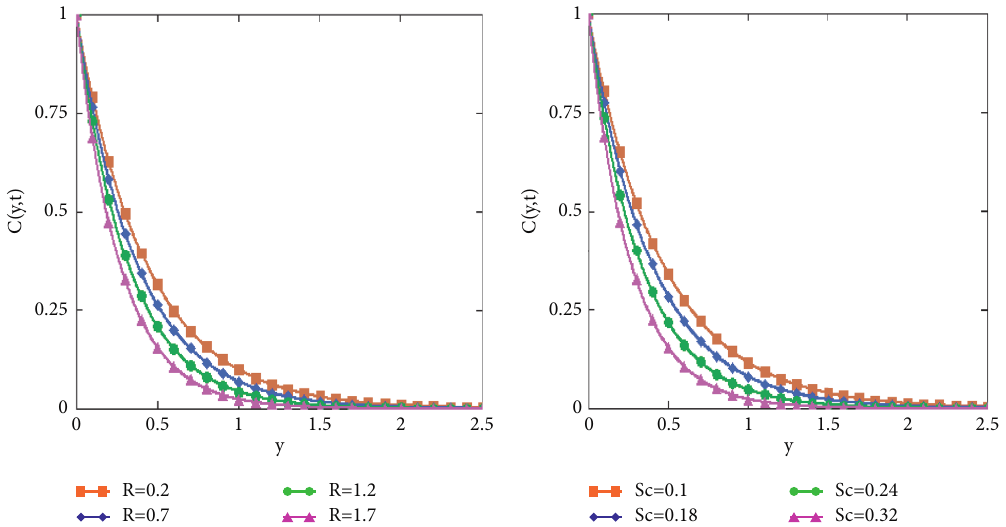
Figure 8: C ( y,t ) for distinct values of chemical reaction parameter R and Sc at α � 0 .